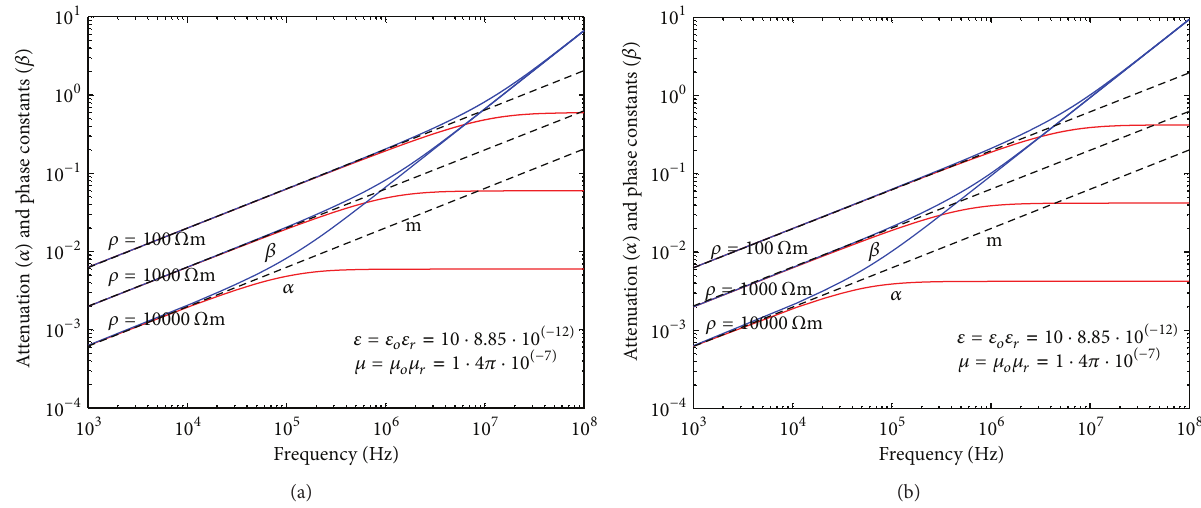
Figure 2: (a) The attenuation ( 𝛼 ) and phase ( 𝛽 ) constants in a dissipative medium with 𝜀 𝑟 = 10 and 𝜌 = 100, 1000 , and 10000 Ω m. (b) The phase and attenuation constants in a dissipative medium with 𝜀 𝑟 = 20 . 𝛼 is the attenuation (red lines) as Nepers/m and 𝛽 is the phase constant (blue lines) as rad/m. The m-curve is valid when the attenuation constant equals the phase constant or 𝛼 ≈ 𝛽 (black